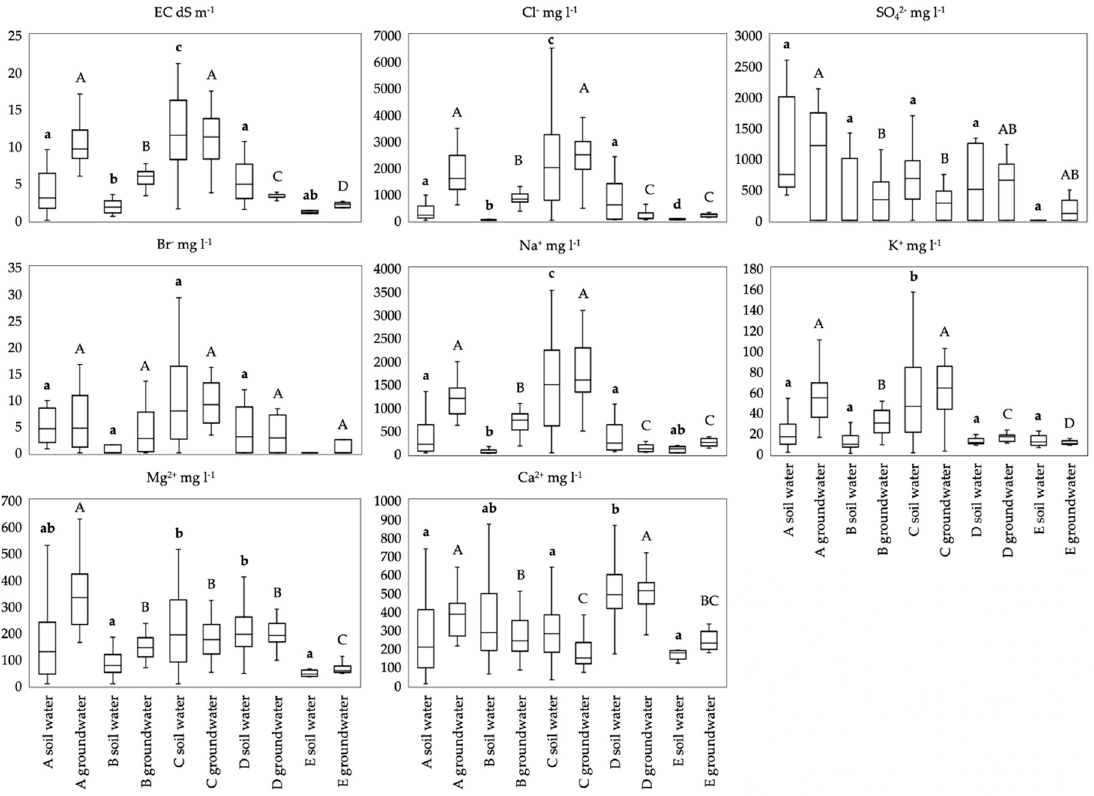
Figure 4. Box plot of electrical conductivity (EC) and ion concentration in soil water and groundwater of each monitoring station. Letters refer to post-hoc statistical analysis (Wilcoxon test on each pair). Different lowercase letters indicate significant differences between soil water data, while capital letters refer to groundwater data. α was corrected for multiple comparisons using the Bonferroni procedure ( α = 0.005).